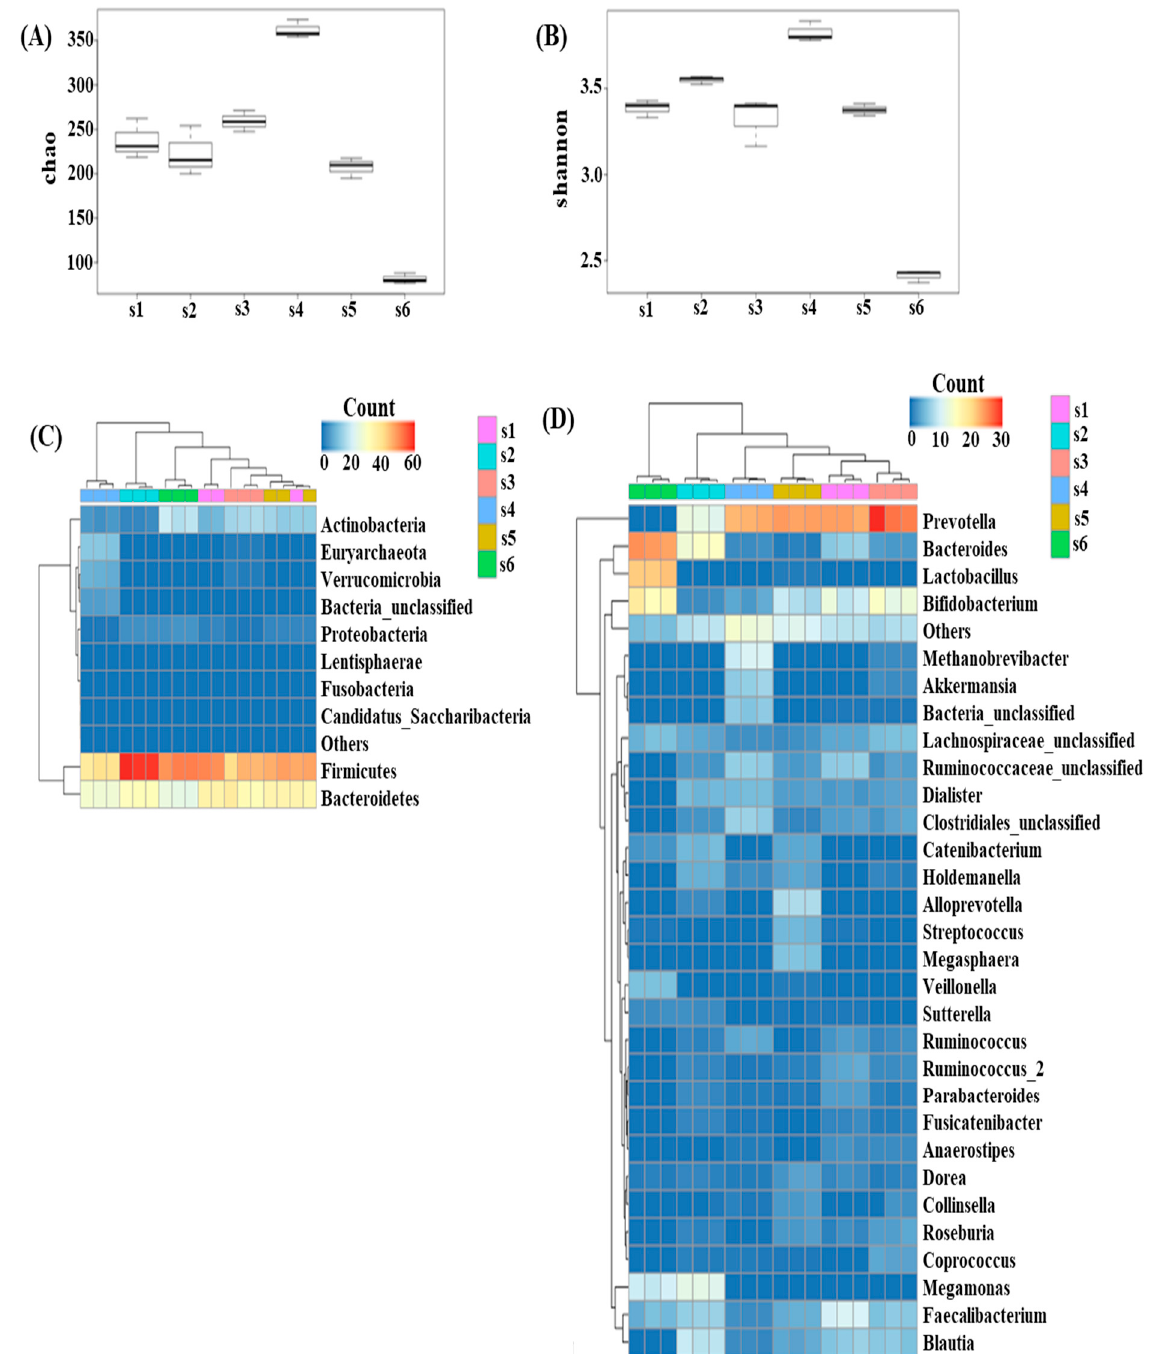
Figure 1. Microbial diversity among the donors (alpha diversity) showed varied richness ( A ) and diversity ( B ). Microbial strata among the fecal donors also found to be individualistic at the phylum ( C ) and genus level ( D ).